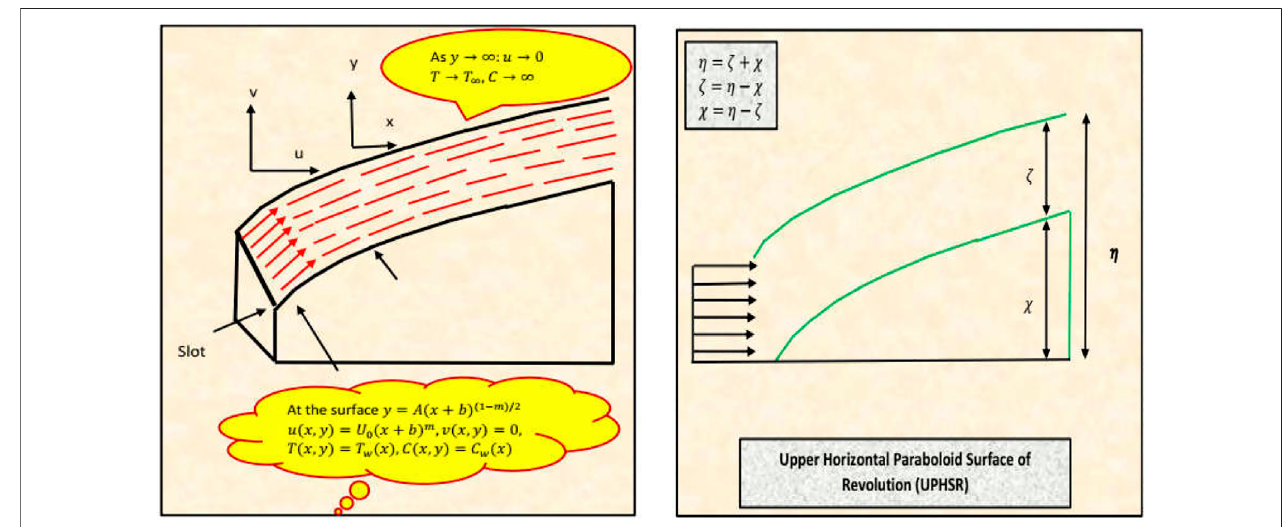
FIGURE 1 | | Floe con fi guration over a